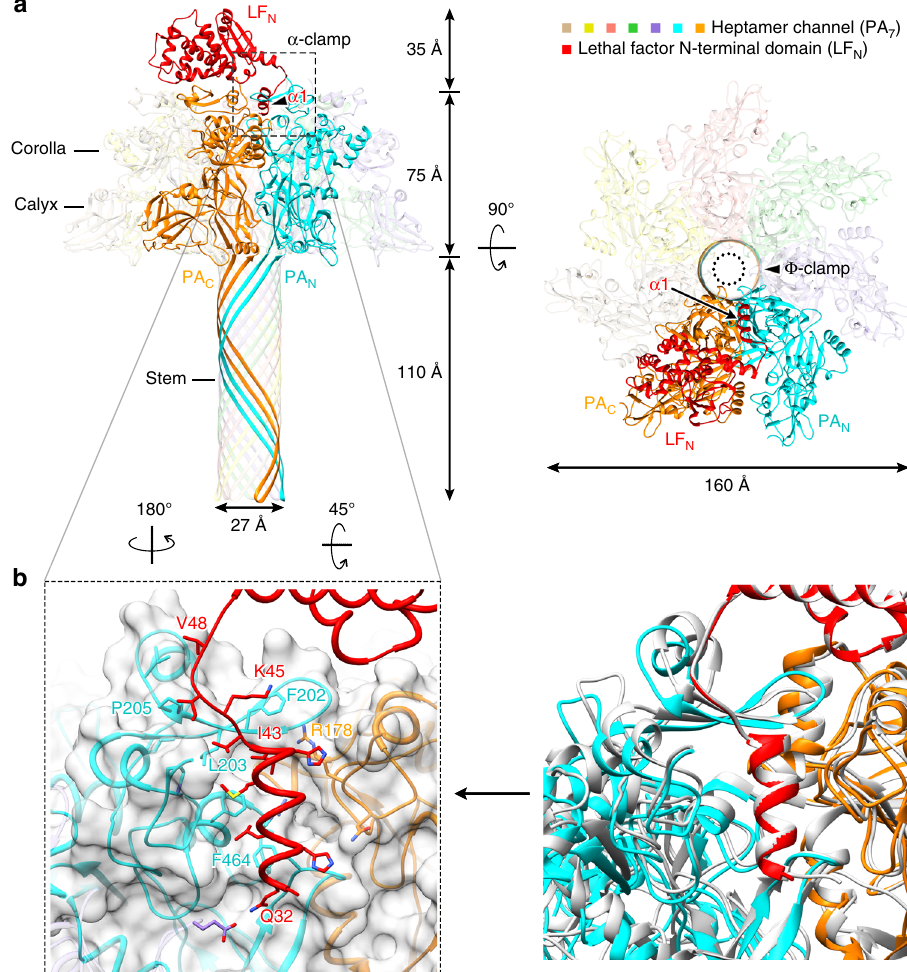
Fig. 1 Structure of LF-bound PA 7 channel (PA 7 -LF). a Two orthogonal views of the overall PA 7 -LF structure. b Structure comparison of substrate-binding α clamp between PA 7 -LF channel and PA 8 -(LF N ) 4